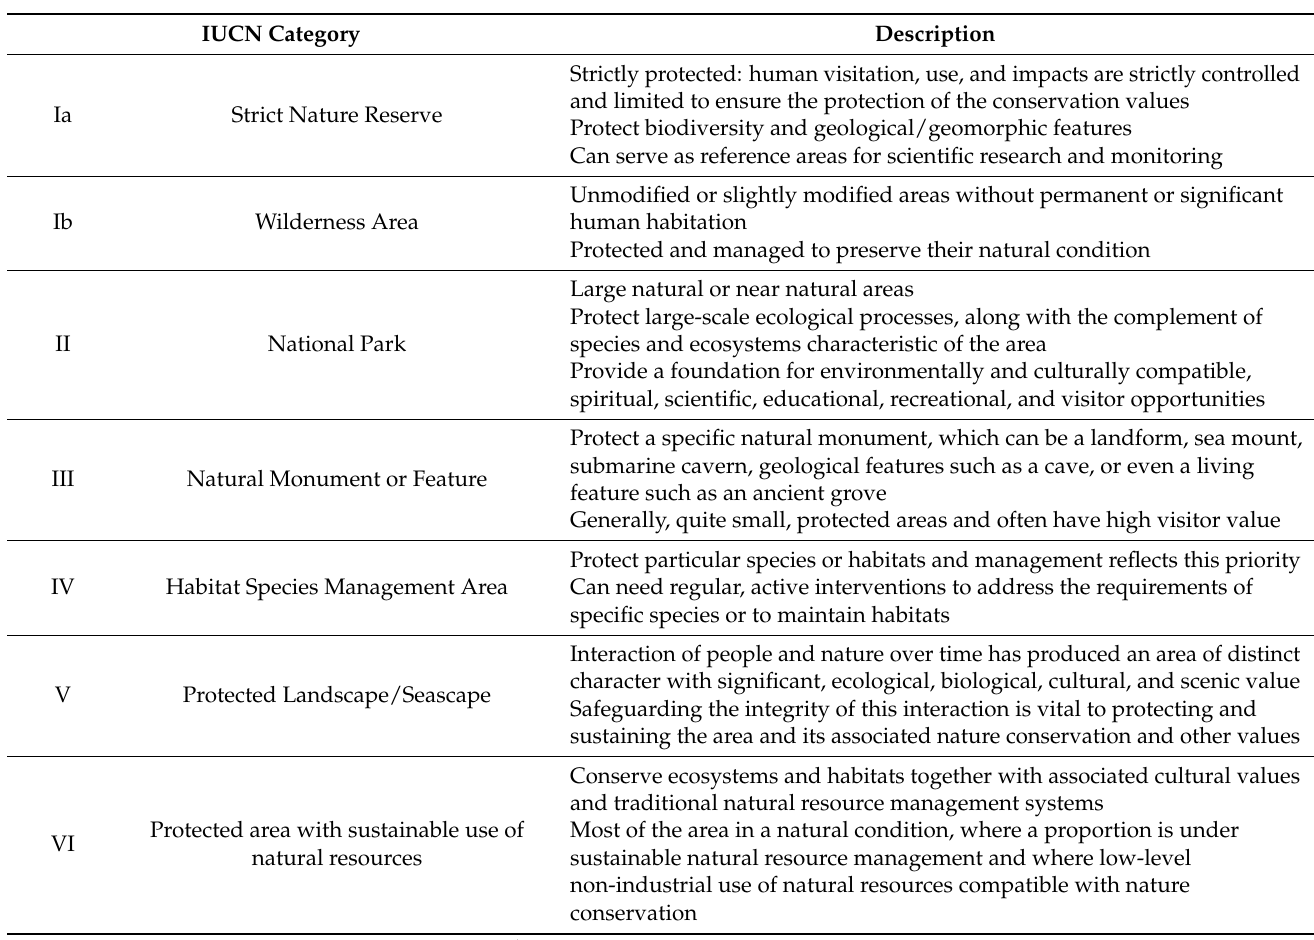
Table A1. Protected area management categories’ definitions from IUCN 1 .